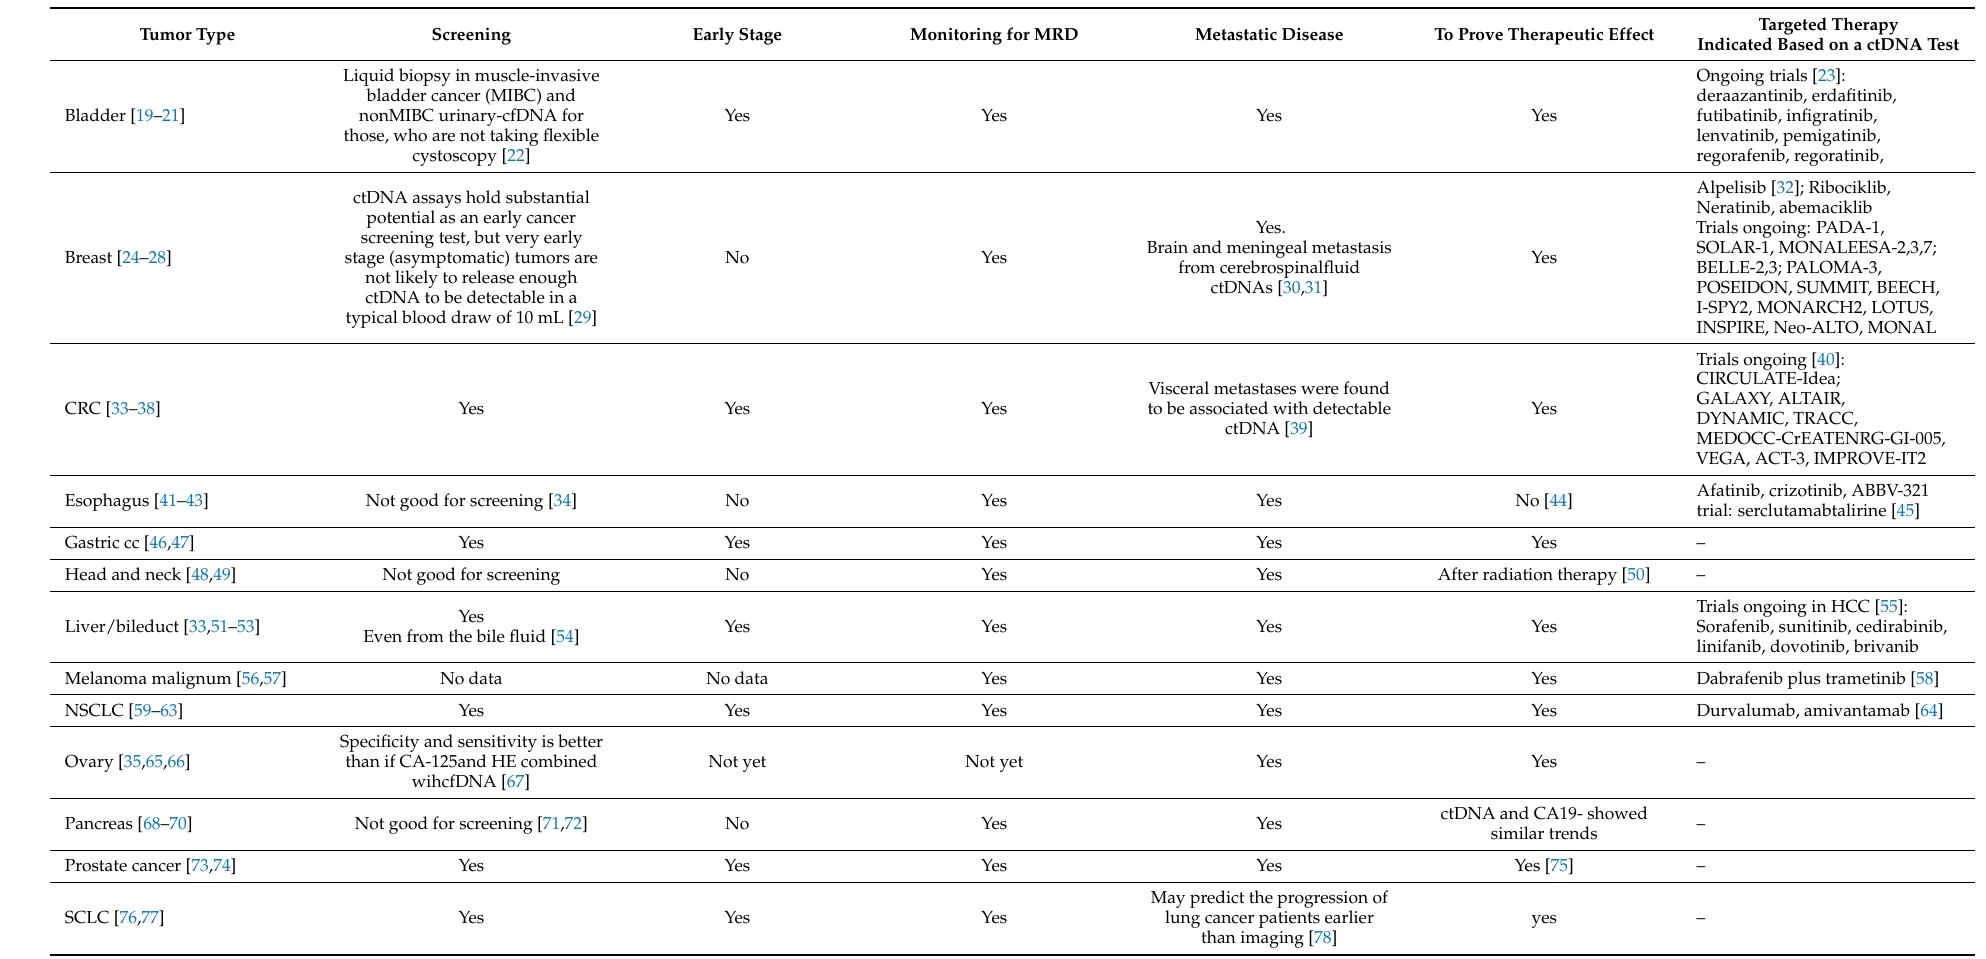
Table 2. Future possibilities in the clinical management of ctDNA in solid tumors